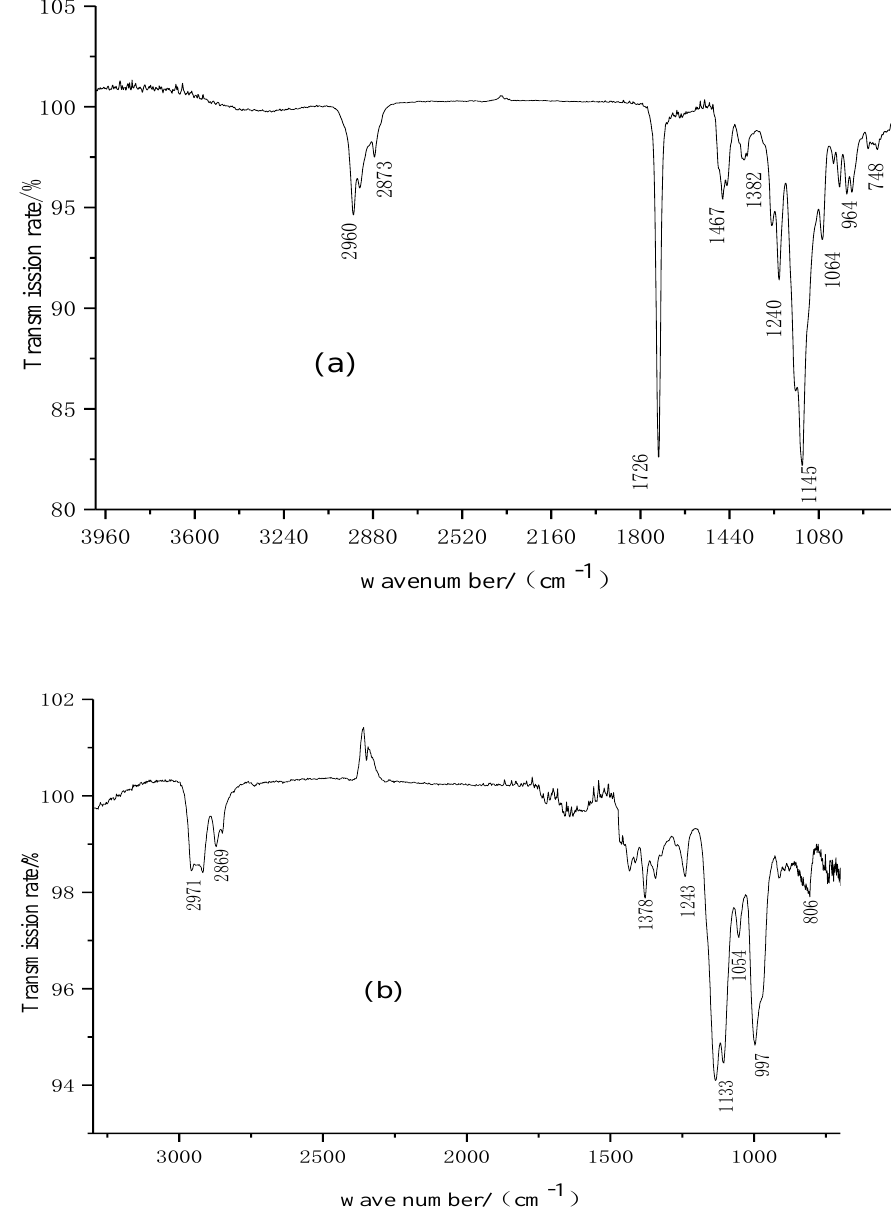
Figure 2. FT-IR analysis of water transfer paper ( a ) and PVB flower paper ( b ).